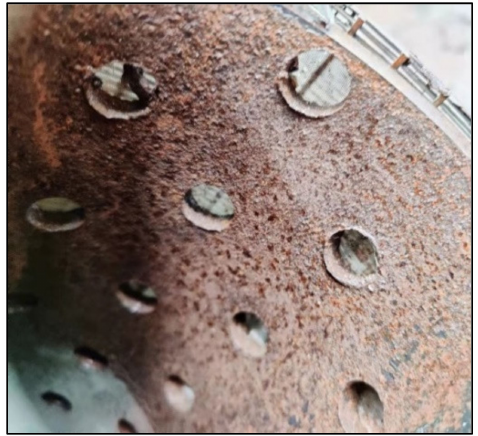
Figure 7. Interior of the screen tube and the screen after the